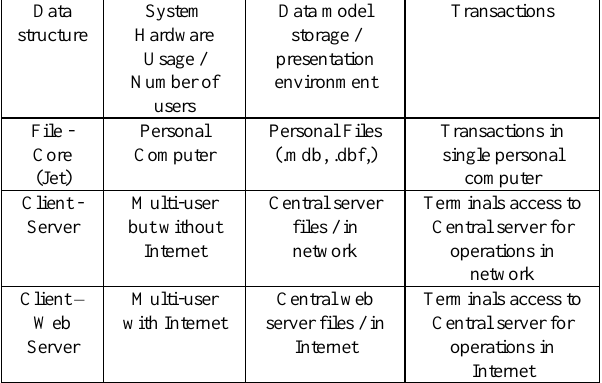
Table 6. Overview of computer architecture basics.